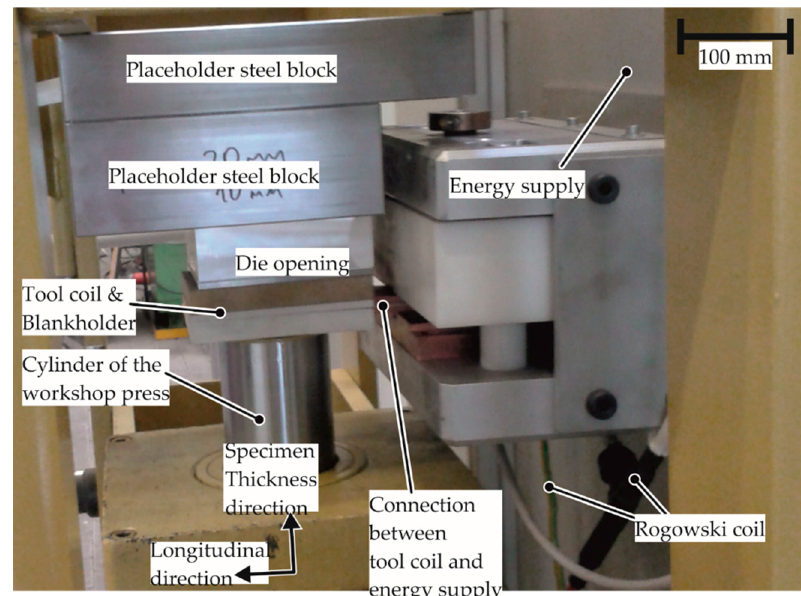
Figure 9. The setup of the electromagnetic forming limit test. The specimen is not seen; it is fixed between the tool coil and the die opening. A Photon Doppler Velocimeter (PDV) is also not seen; it is nestling in the uppermost steel block used as placeholder.